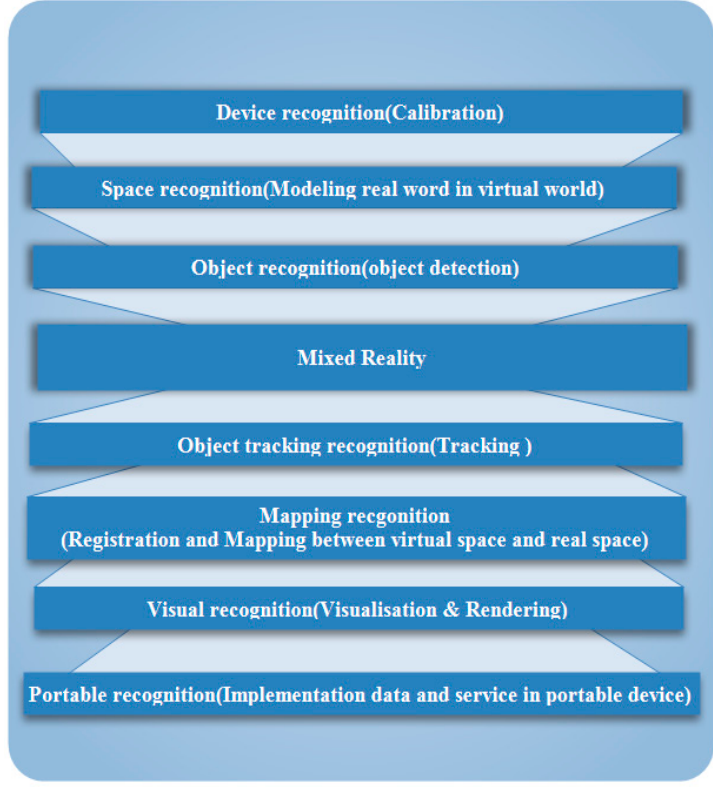
Figure 4. Mixed reality steps.